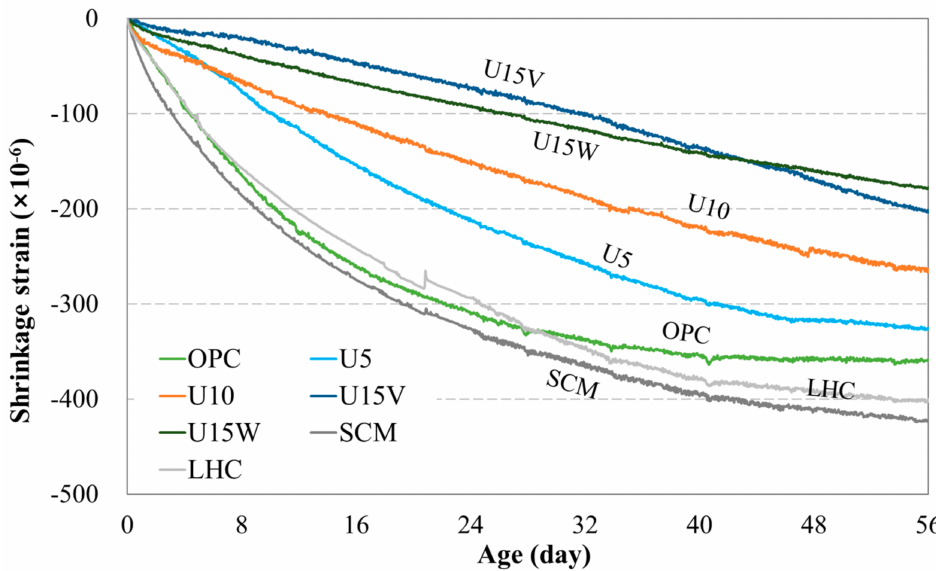
Figure 6. Dry shrinkage strain of the concrete mixture.